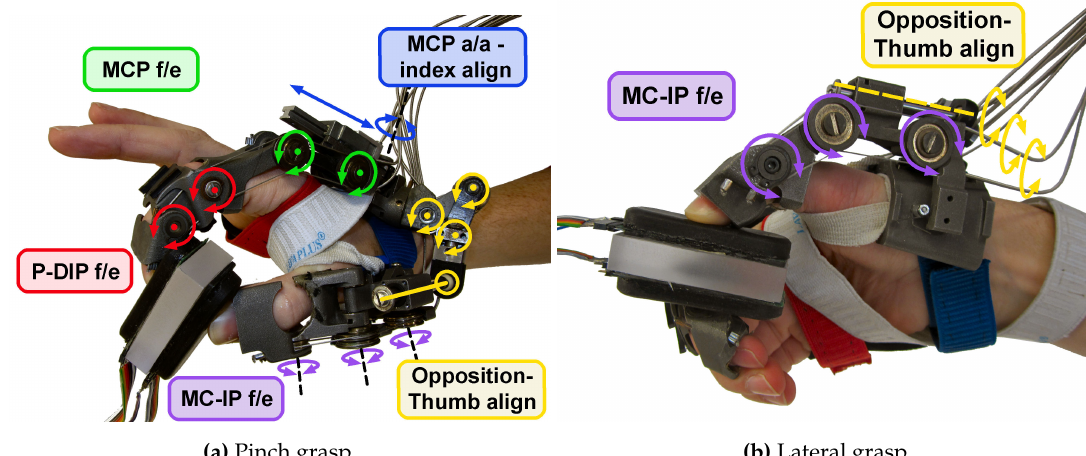
Figure 2. HX while holding the sensorized object in a pinch ( a ) and lateral ( b ) grasping exercise. The DoMs of the HX device are: (1) the flexion/extension of the index MCP; (2) of the index P-DIP (under-actuated); (3) of the thumb MCP and IP (under-actuated) and (4) the CMC opposition. Other Degrees-of-Freedom (DoF), like thumb intra/extra rotation and the index abduction/adduction, are passive [29]. The HX is used to grasp the sensorized object, whose squeezable soft-pads provide force information on the basis of a optoelectronic deformation transduction